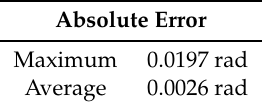
Table 2. Absolute error analysis.